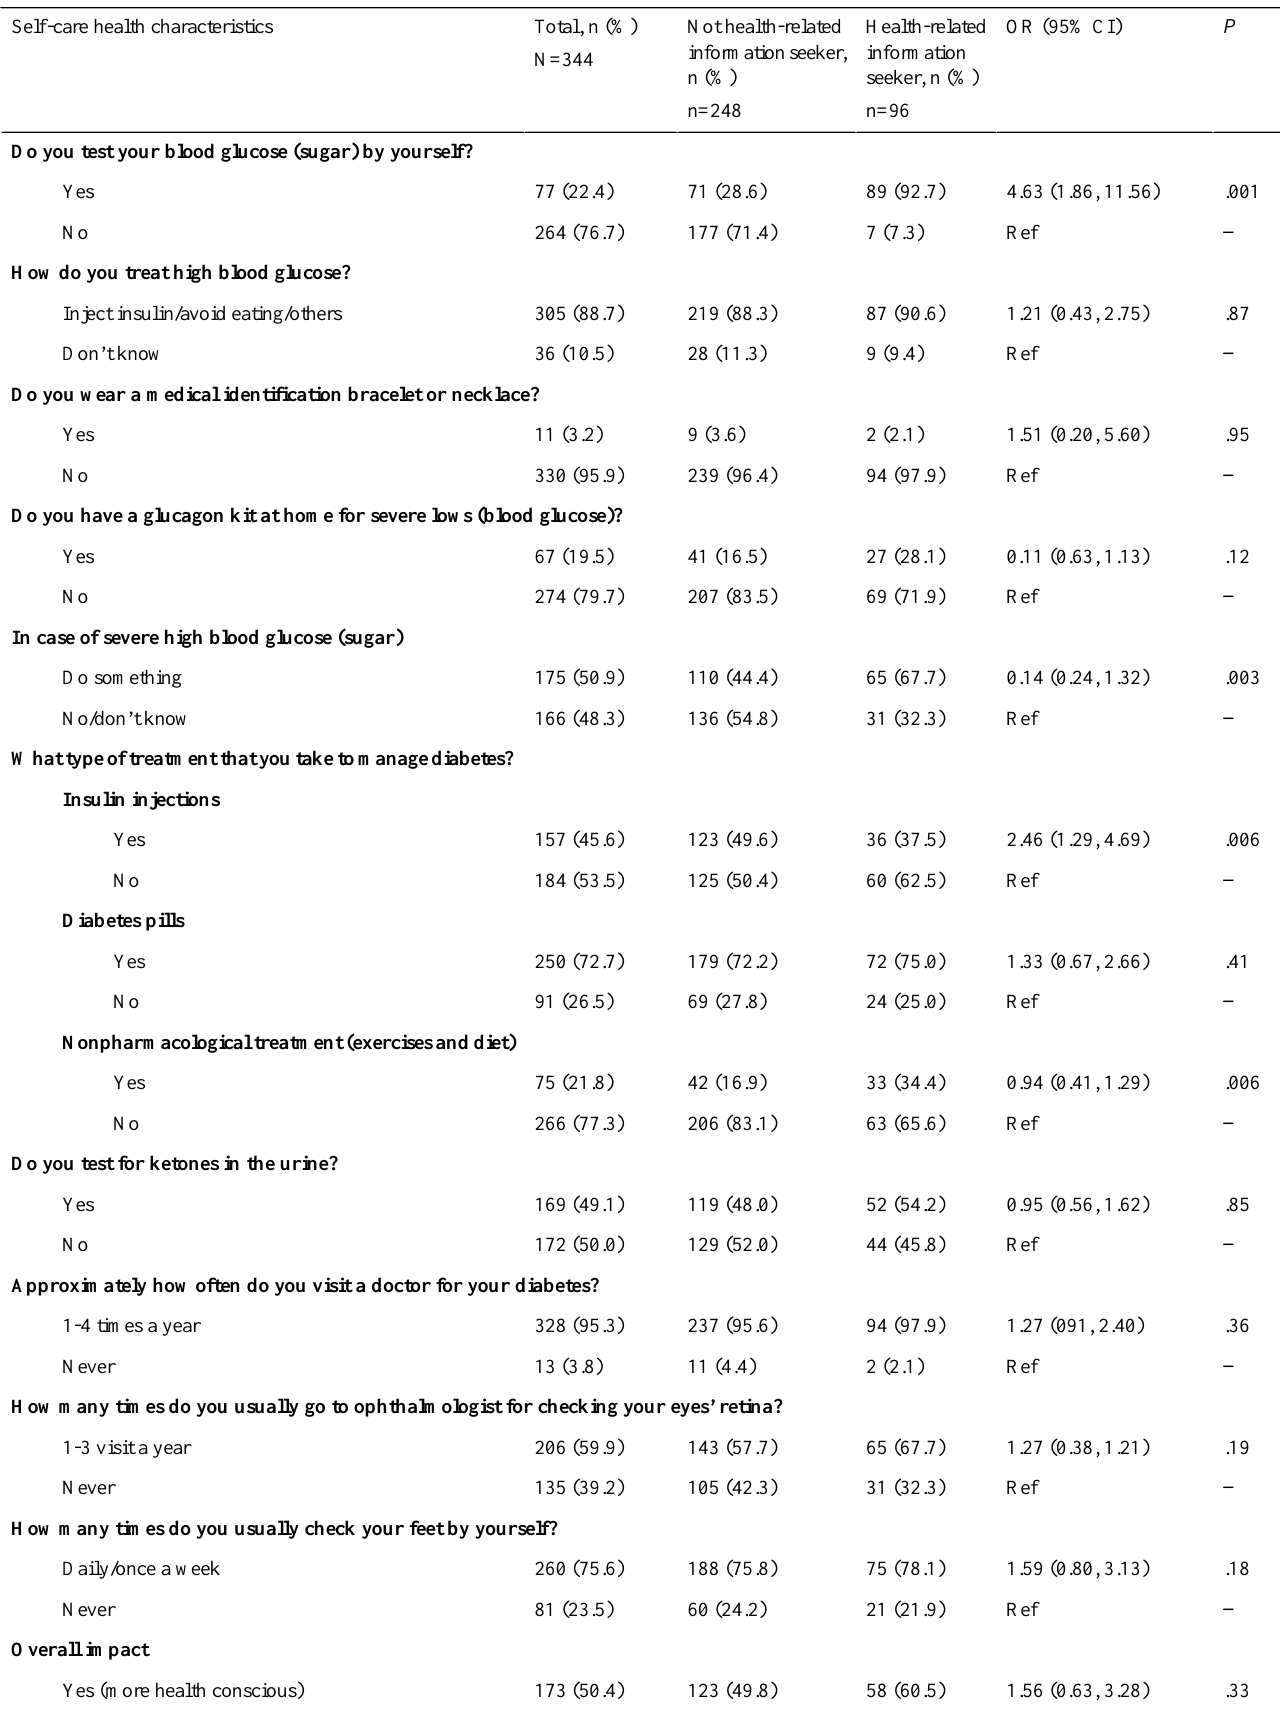
Table 5. Logistic regression to predict impact of health-related information seekers and nonseekers on self-health care